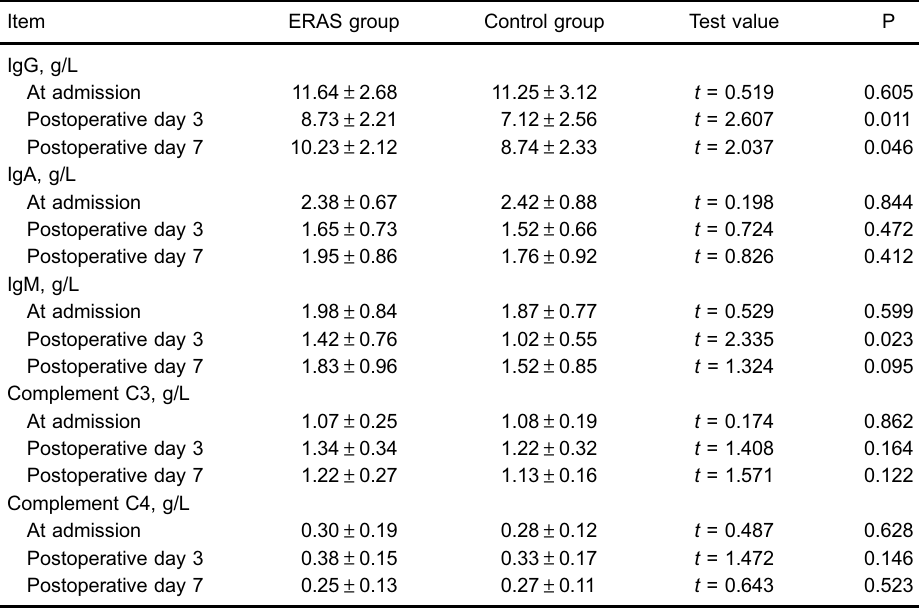
Table 7. Comparison of immunoglobulin and complement levels between the two groups of patients.